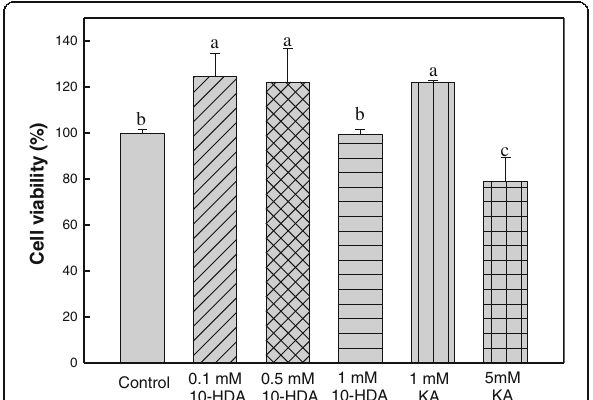
Fig. 3 Inhibitory effect of 10-HDA on tyrosinase activity in B16F1 cells. Cellular tyrosinase activity was measured using B16F1 melanoma cell lysates. Data are presented as mean ± SEM of three independent experiments. Different symbol indicates a significant difference. * P < 0.05 is considered to be